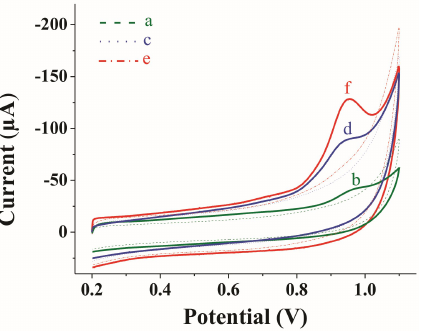
Figure 3. CVs of (a, b) GCE/GO, (c, d) GCE/GO–Pt, and (e, f) GCE/GO–PtCo with (a, c, e) 0 µM and (b, d, f) 9.00 µM TZ in acetate buffer solution (pH = 6.0). Scan rate: 0.1 V/s. (b, d, f) 9.00 µ M TZ in acetate buffer solution (pH = 6.0). Scan rate: 0.1